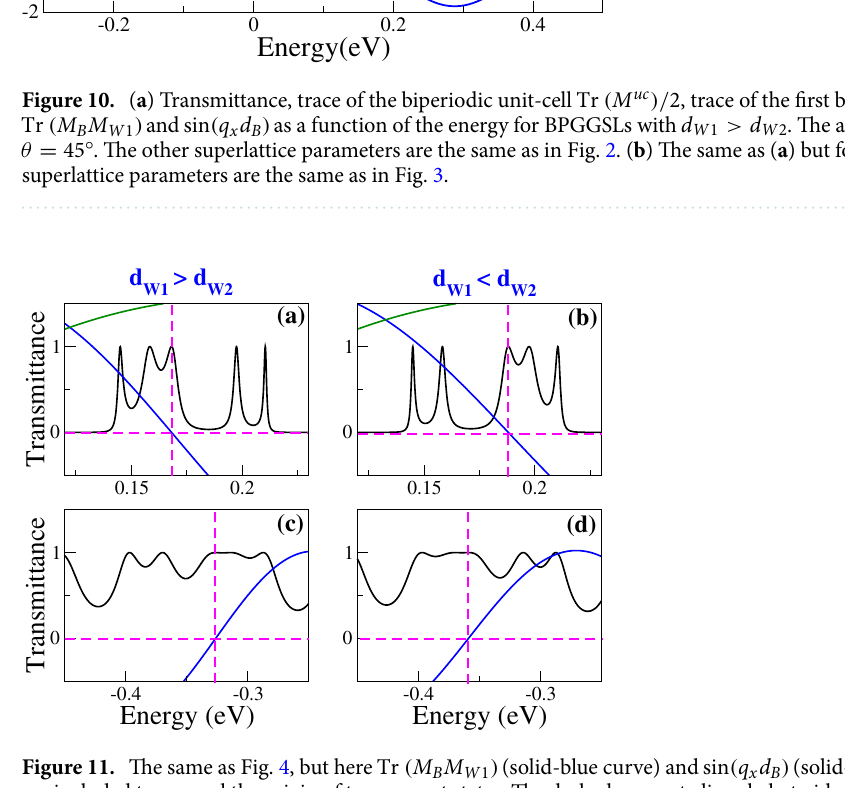
Figure 11. The same as Fig. 4, but here Tr ( M B M W 1 ) (solid-blue curve) and sin ( q x d B ) (solid-dark-green curve) are included to unravel the origin of transparent states. The dashed-magenta lines help to identify the energies at which Tr ( M B M W 1 ) and sin ( q x d B ) are